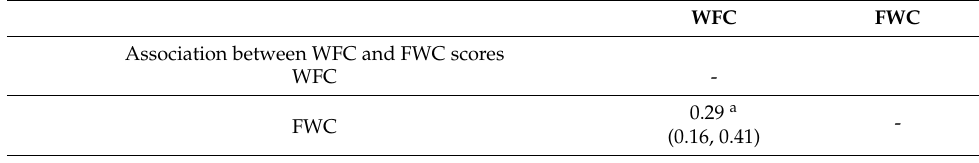
Table 6. Association with other